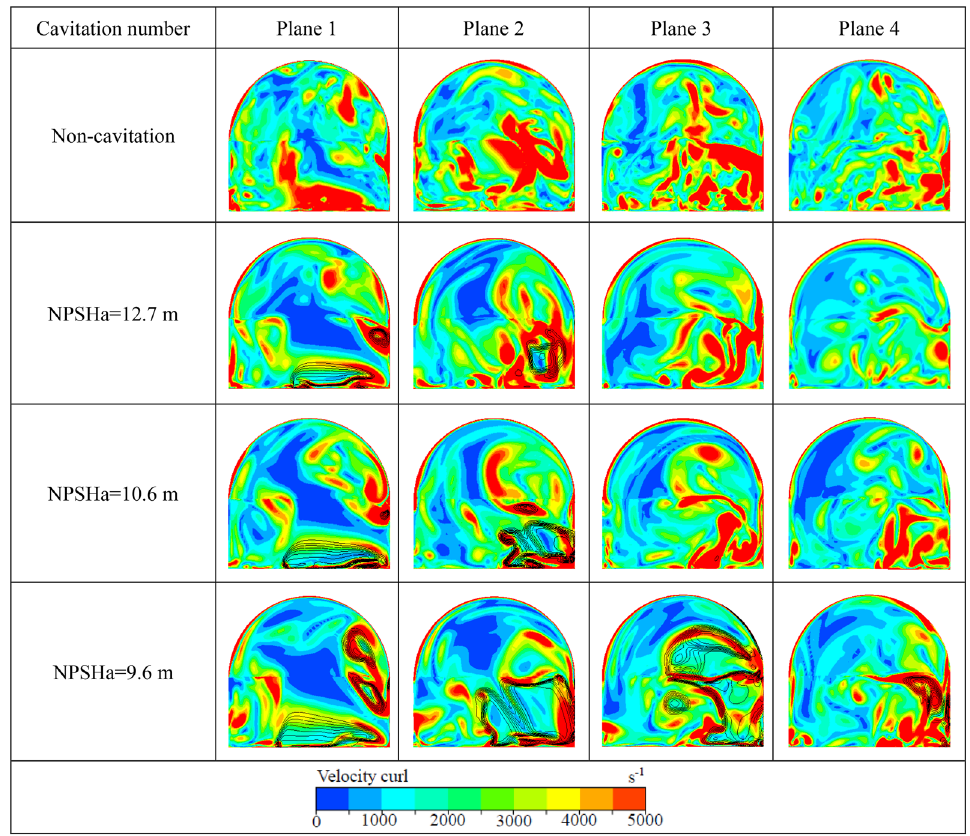
Figure 12 Contour of velocity curl at a typical instant ( t